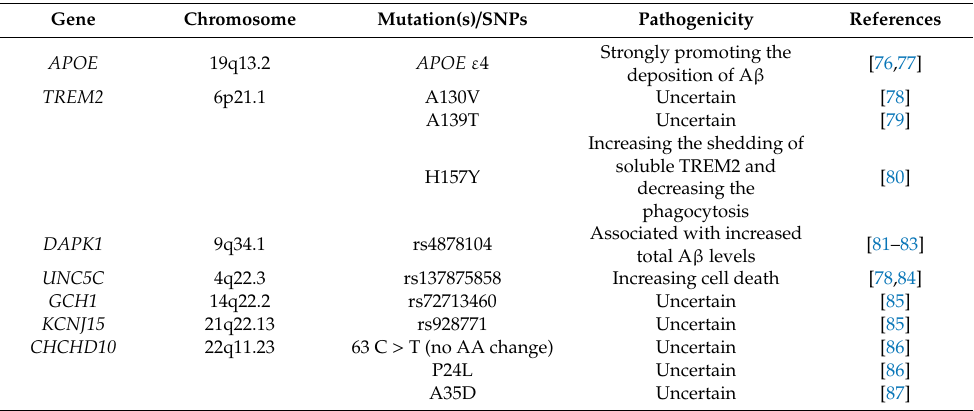
Table 2. Common and rare variants associated with sporadic / late onset (LOAD), as reported in the Chinese